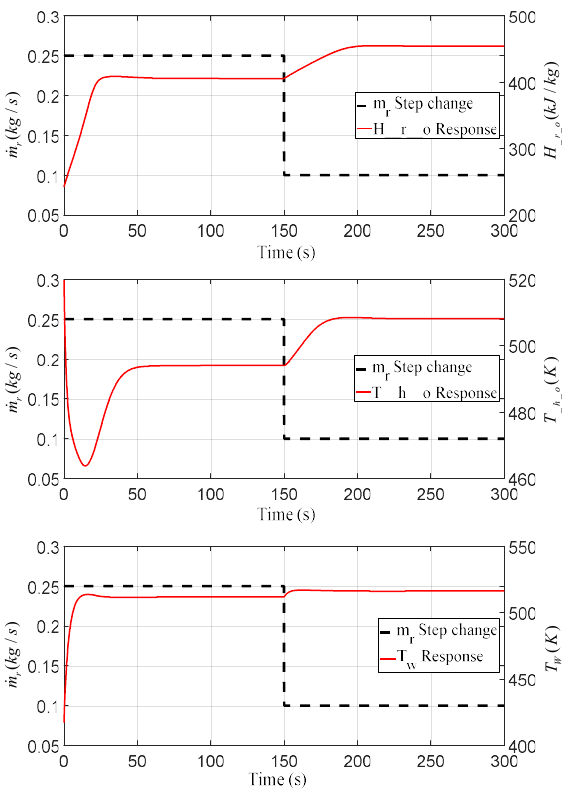
. m r step change.